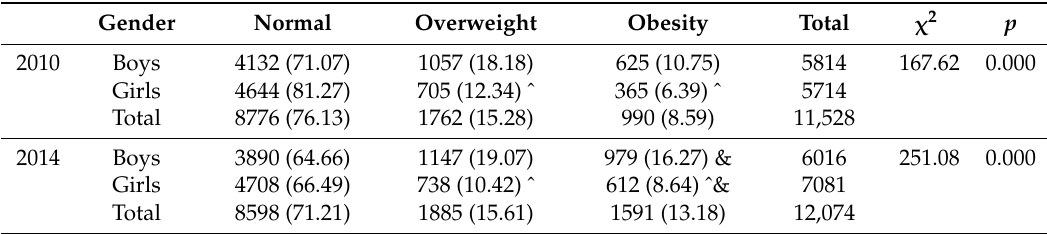
Table 3. The prevalence of obesity and overweight among gender in 2010 and 2014 (%). Gender Normal Overweight